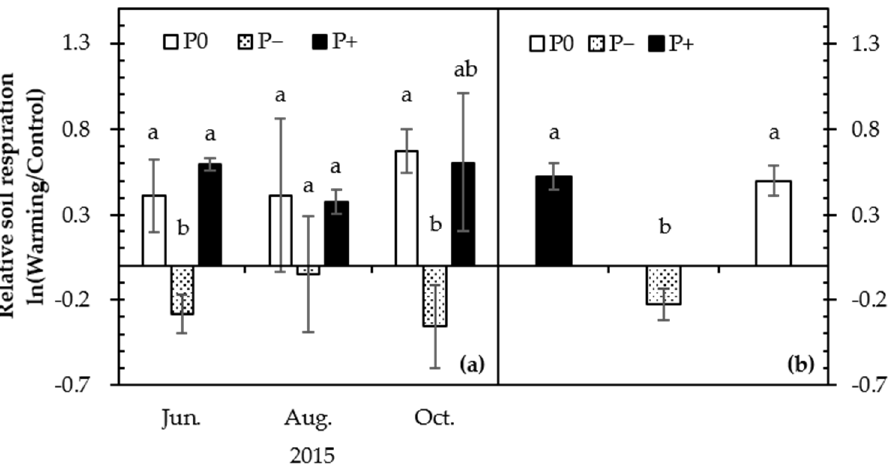
Figure 2. ( a ) Variations in relative soil respiration between the warmed plots and non ‐ warmed plots subjected to three precipitation manipulations; ( b ) mean relative soil respiration between the warmed plots and non ‐ warmed plots under different precipitation manipulations. Vertical bars indicate the standard error. Different lower ‐ case letters represent significant differences ( p < 0.05). Treatments: P0 = precipitation control; P − = reduced precipitation; P+ = elevated precipitation.